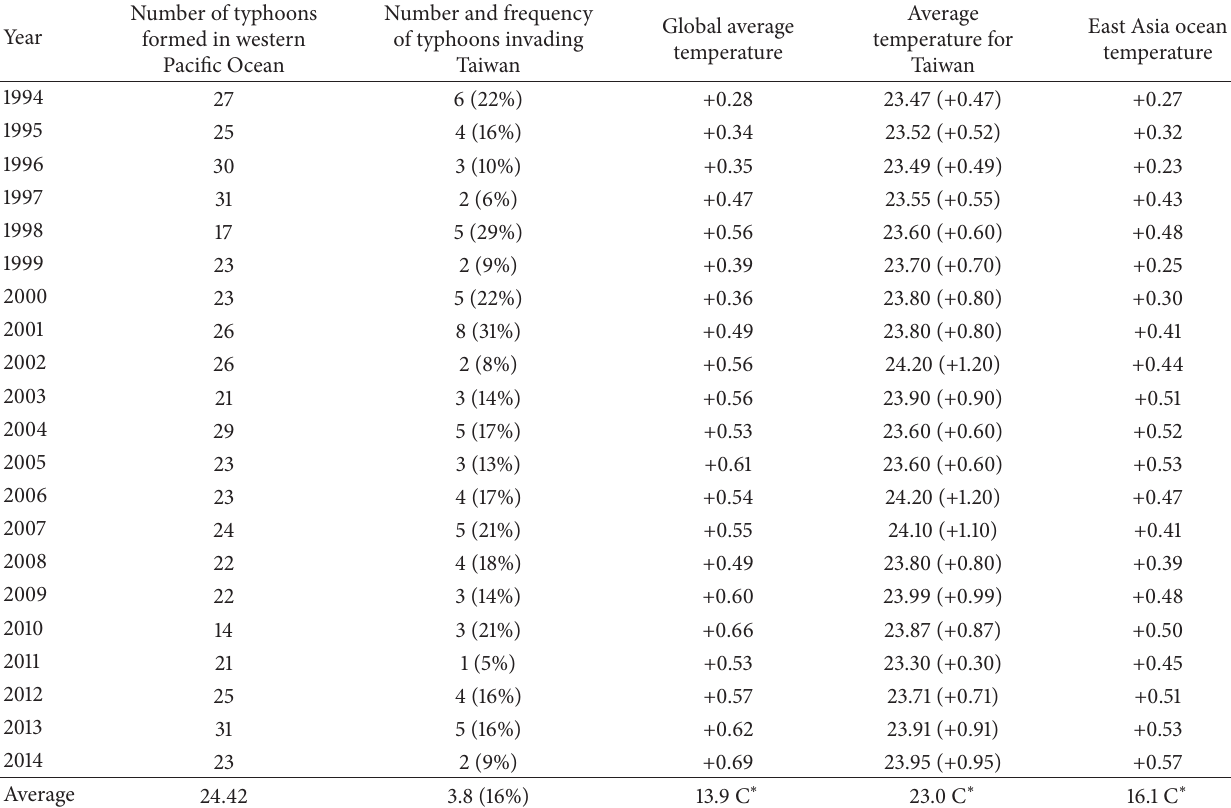
Table 1: Frequency of typhoon formation in the western Pacific Ocean and typhoon invasions in Taiwan from 1994 to